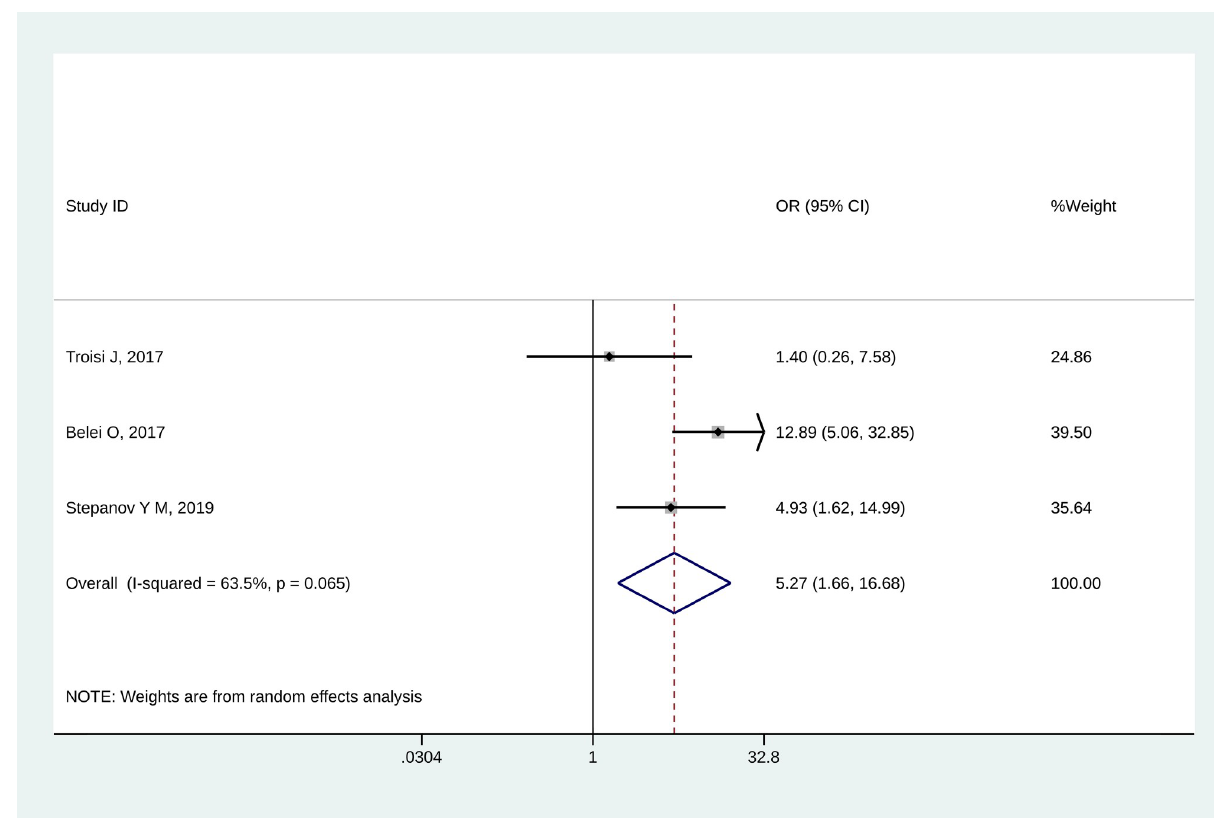
Fig 2. Forest plot of